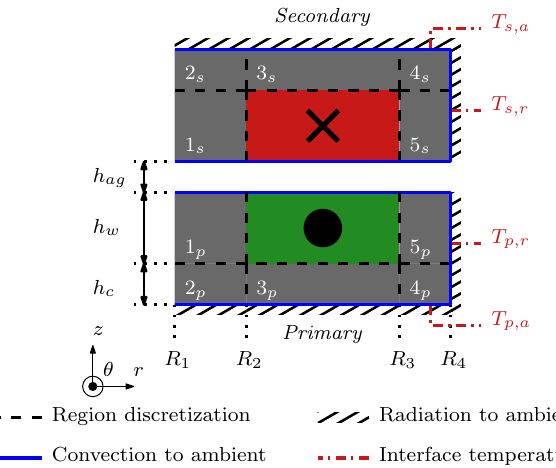
Figure 2. Two-dimensional representation of the pot core transformer geometry in the axisymmetrical plane, including indication of geometrical parameters, region discretization, thermal boundaries, and interface